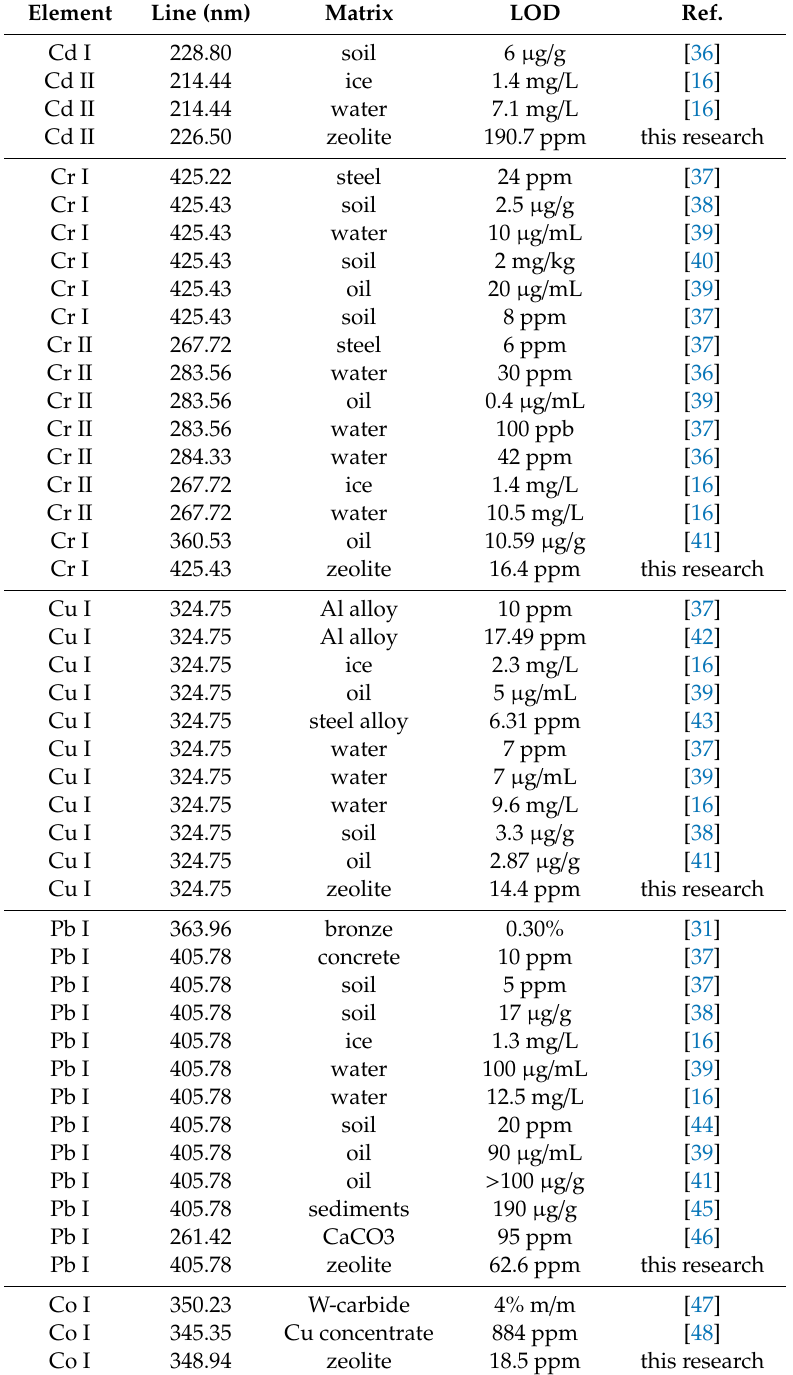
Table 5. Limits of detection of five heavy